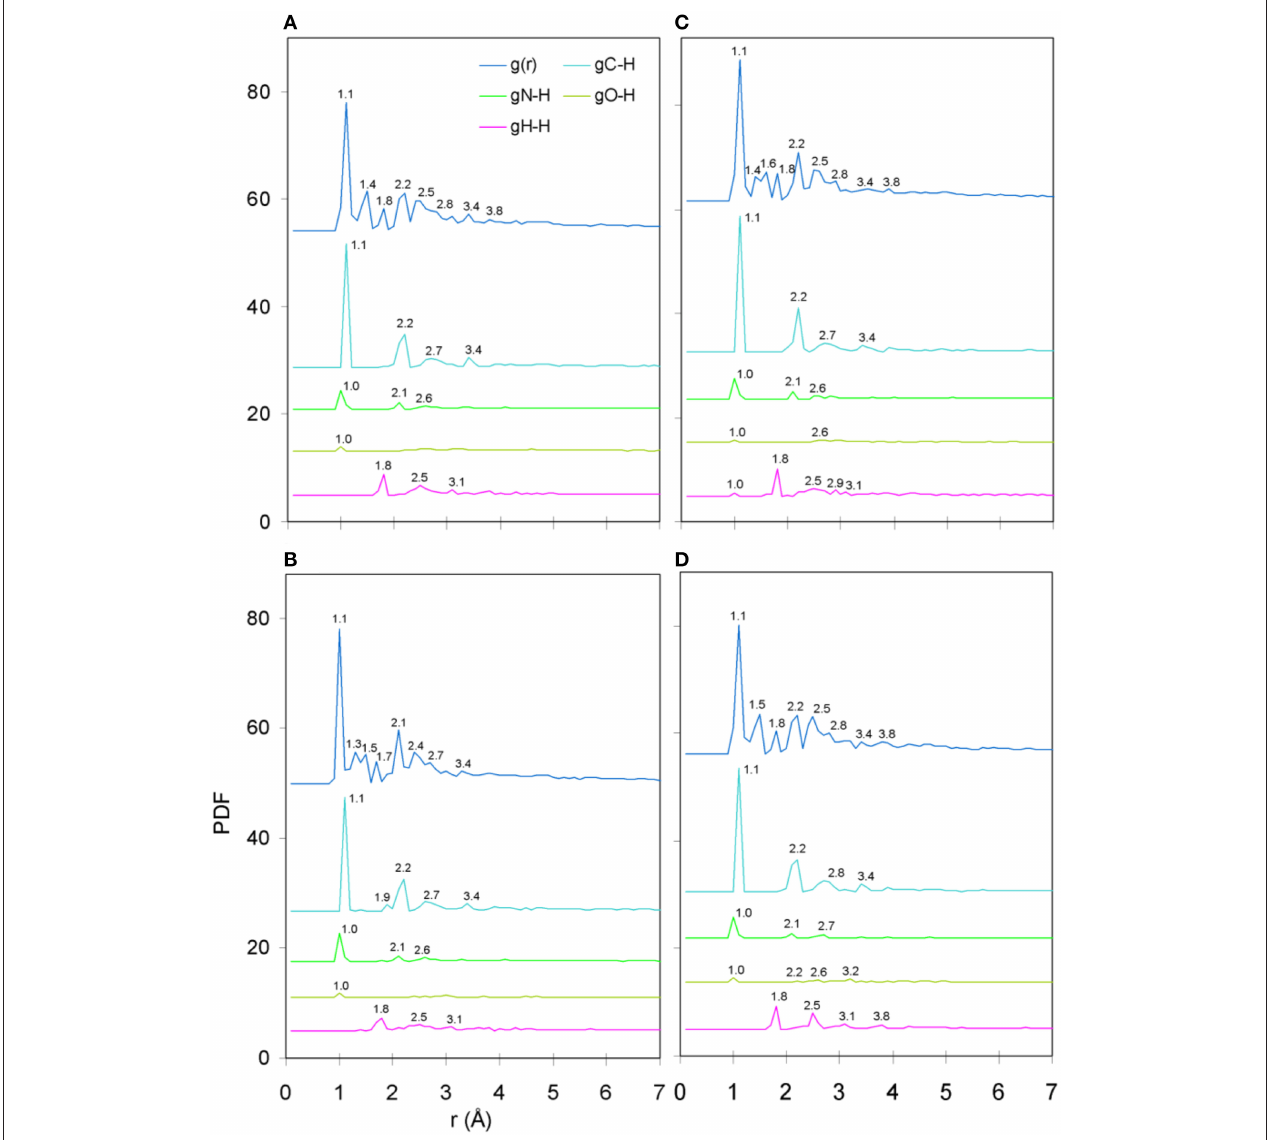
FIGURE 6 | PDF diagrams of the H species partials for protonated, spin unpolarized peptide models: (A) Tax, (B) V7R, (C) Y8A, and (D)